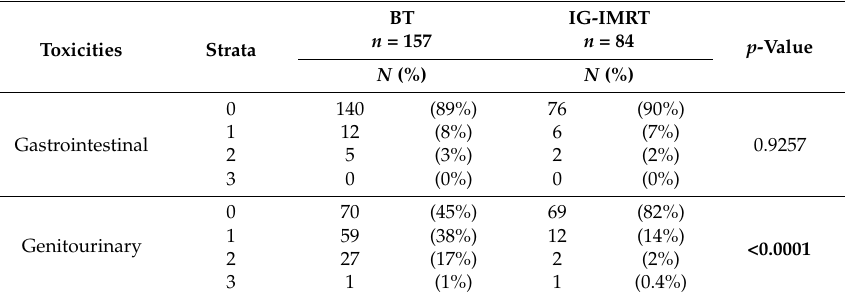
Bold values indicate statistical significance. IG-IMRT = image guided intensity modulated radiotherapy; BT =